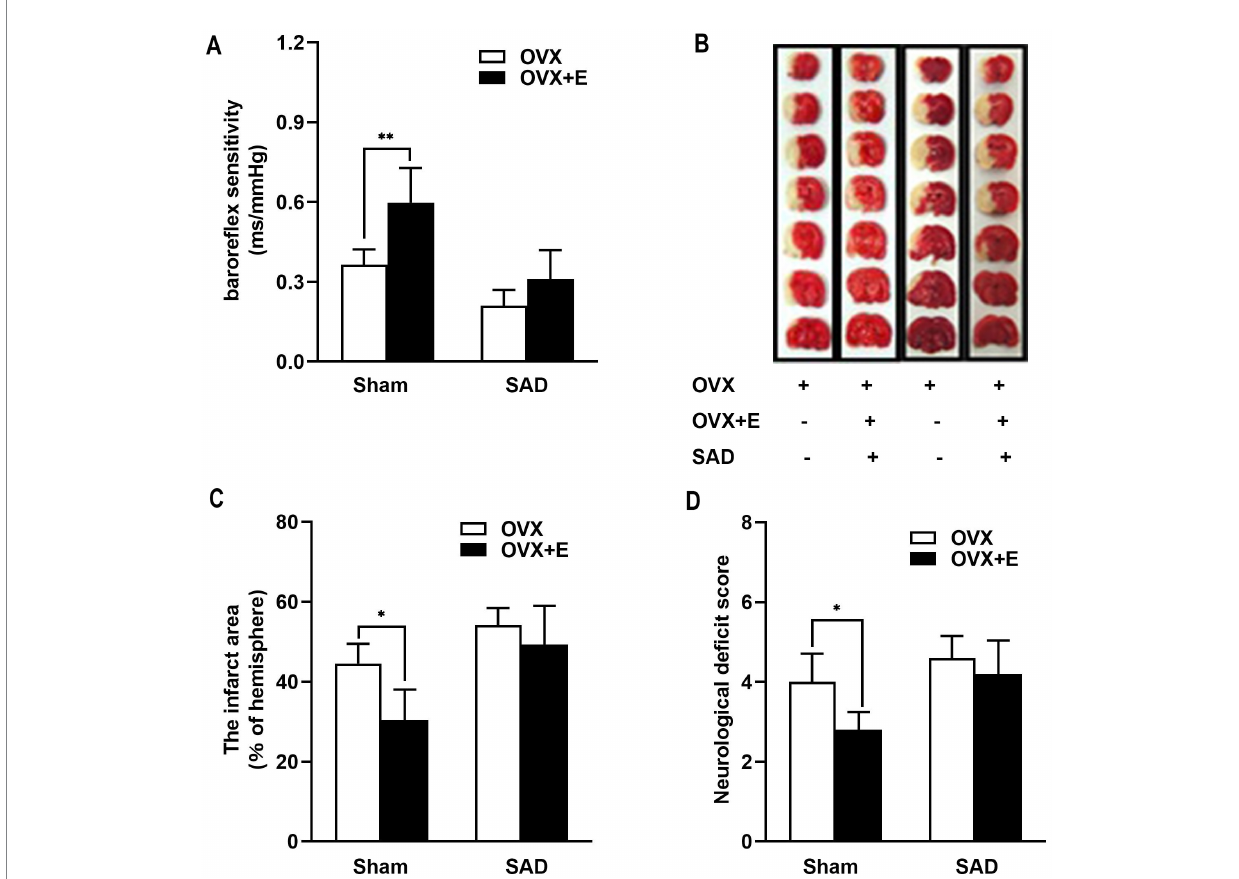
FIGURE 5 Sinoaortic denervation (SAD) impaired the function of arterial baroreflex and attenuated the improvement in BRS and neuroprotective effects of estrogen in adult OVX rats. (A) Estrogen supplements improved BRS compared with OVX rats, whereas SAD impaired the function of arterial baroreflex and abolished the beneficial action of estrogen on BRS. (B,C) Estrogen supplements reduced the infarct area in rats with an intact baroreflex by 31.72% and to a much lesser degree in SAD rats without significant difference (by 8.85%). B shows representative rostrocaudal series of TTC-stained coronal sections 1 day after MCAO. (D) Estrogen supplements also improved the neurological function in OVX rats with intact baroreflex but not in OVX rats with SAD. Data were analyzed by one-way analysis of variance (ANOVA) followed by least significant difference t -test, n = 5–6 in each group. * p < 0.05, ** p <